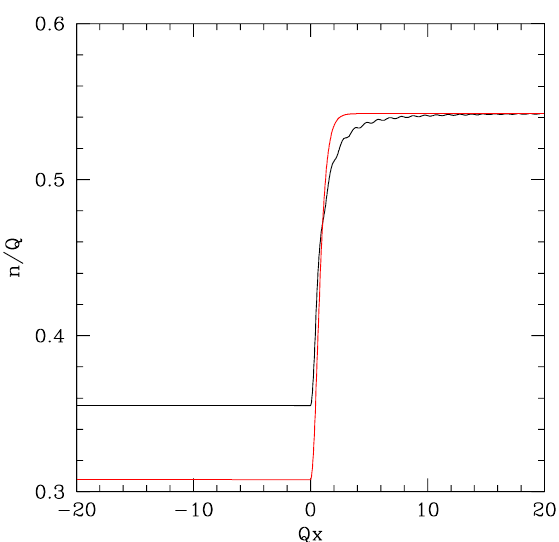
Q (black) compared to the half 2